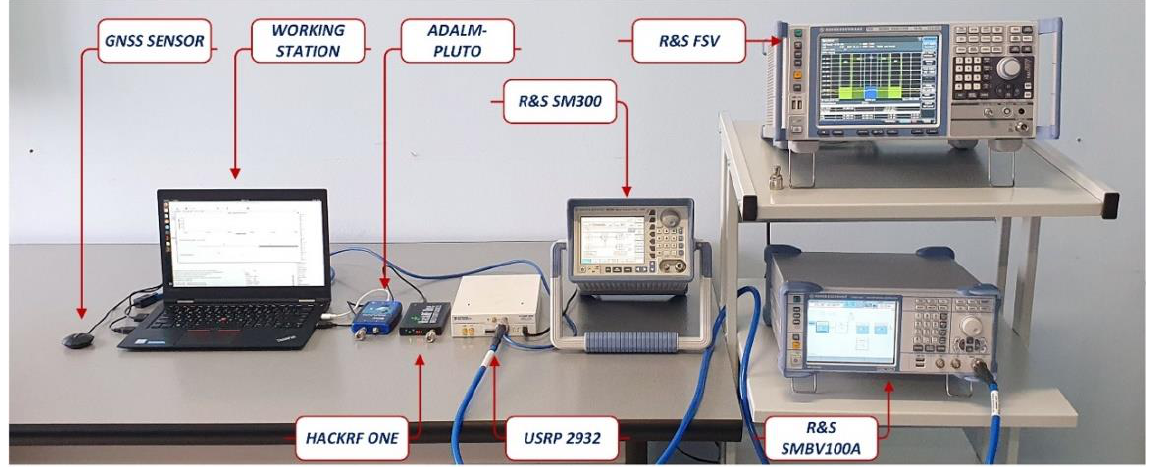
Figure 8. Measurement set-up for laboratory testing.